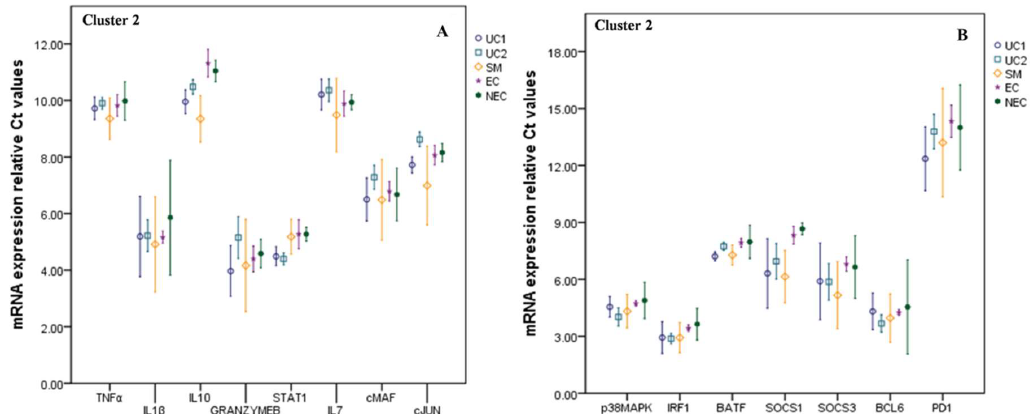
Figure 2. Expressions of these signaling molecules got upregulated following malaria progression and were grouped as Cluster 2. ( A ) Cytokines like TNF- α , IL10, and IL1 β levels were upregulated with an increase in malaria burden. STAT1 expression was moderately upregulated during early infections. Despite downregulated perforin expression, GrB mRNA expression was elevated in severe malaria. Expression levels of IL7 and cJUN were low during the early stages (UC1 and UC2) but were considerably upregulated in severe malaria (SM). ( B ) p38MAPK mRNA expressions were upregulated. Negative regulators of cytokine signaling like SOCS1 and SOCS3 found elevated following malaria burden. T cell exhaustion indicator, PD1 was also got upregulated following malaria burden. Uncomplicated malaria1 (UC1 = parasitemia < 25,000 / µ L), uncomplicated malaria2 (UC2 = parasitemia > 25,000 / µ L), severe malaria (SM), endemic control (EC), non-endemic control (NEC). β -actin was used as an endogenous control. Mean and standard error bars were calculated at a 95% confidence interval (CI). Gene expression decreases as Ct value increases and vice